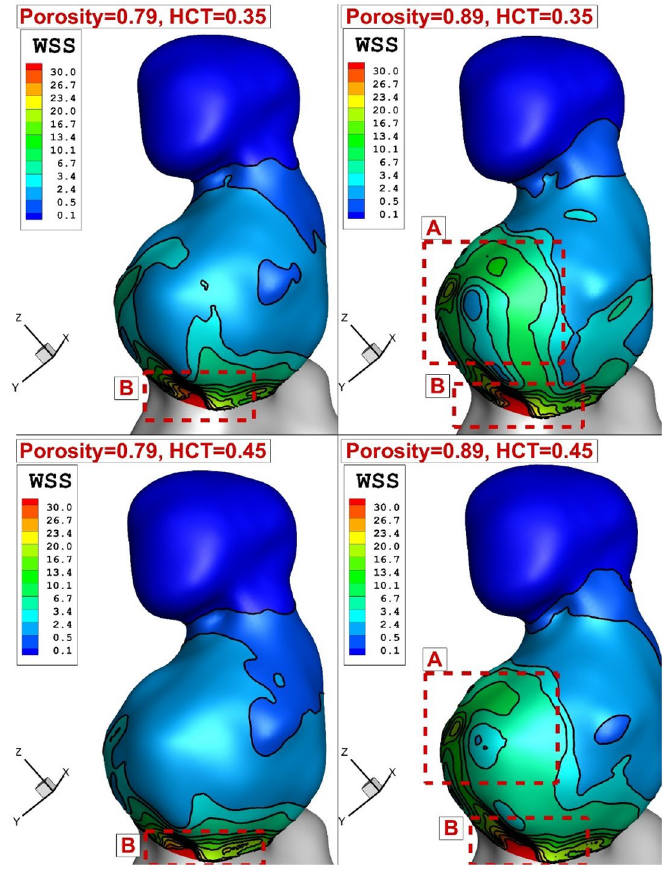
Figure 9. WSS distribution on aneurysm wall in different porosities and HCTs.